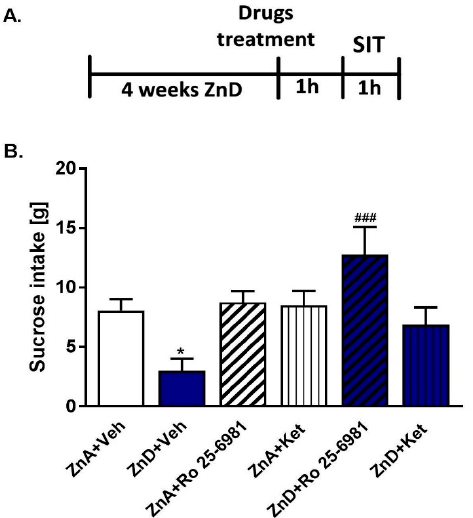
Figure 2. The effect of a single dose of ketamine (Ket) and Ro 25–6981 on sucrose intake in